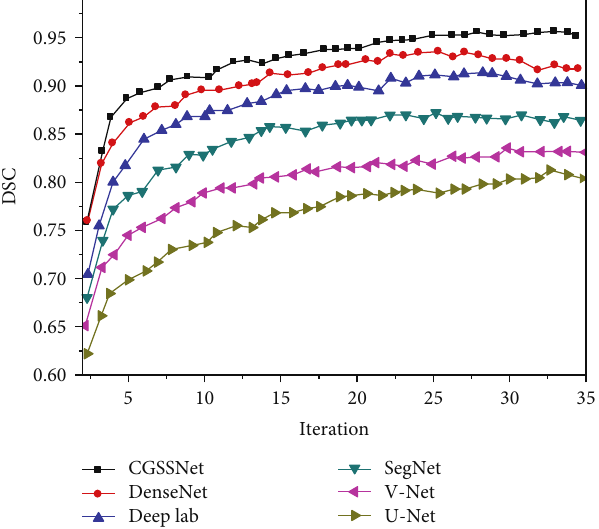
Figure 9: Comparison for DSC of di ff erent methods.